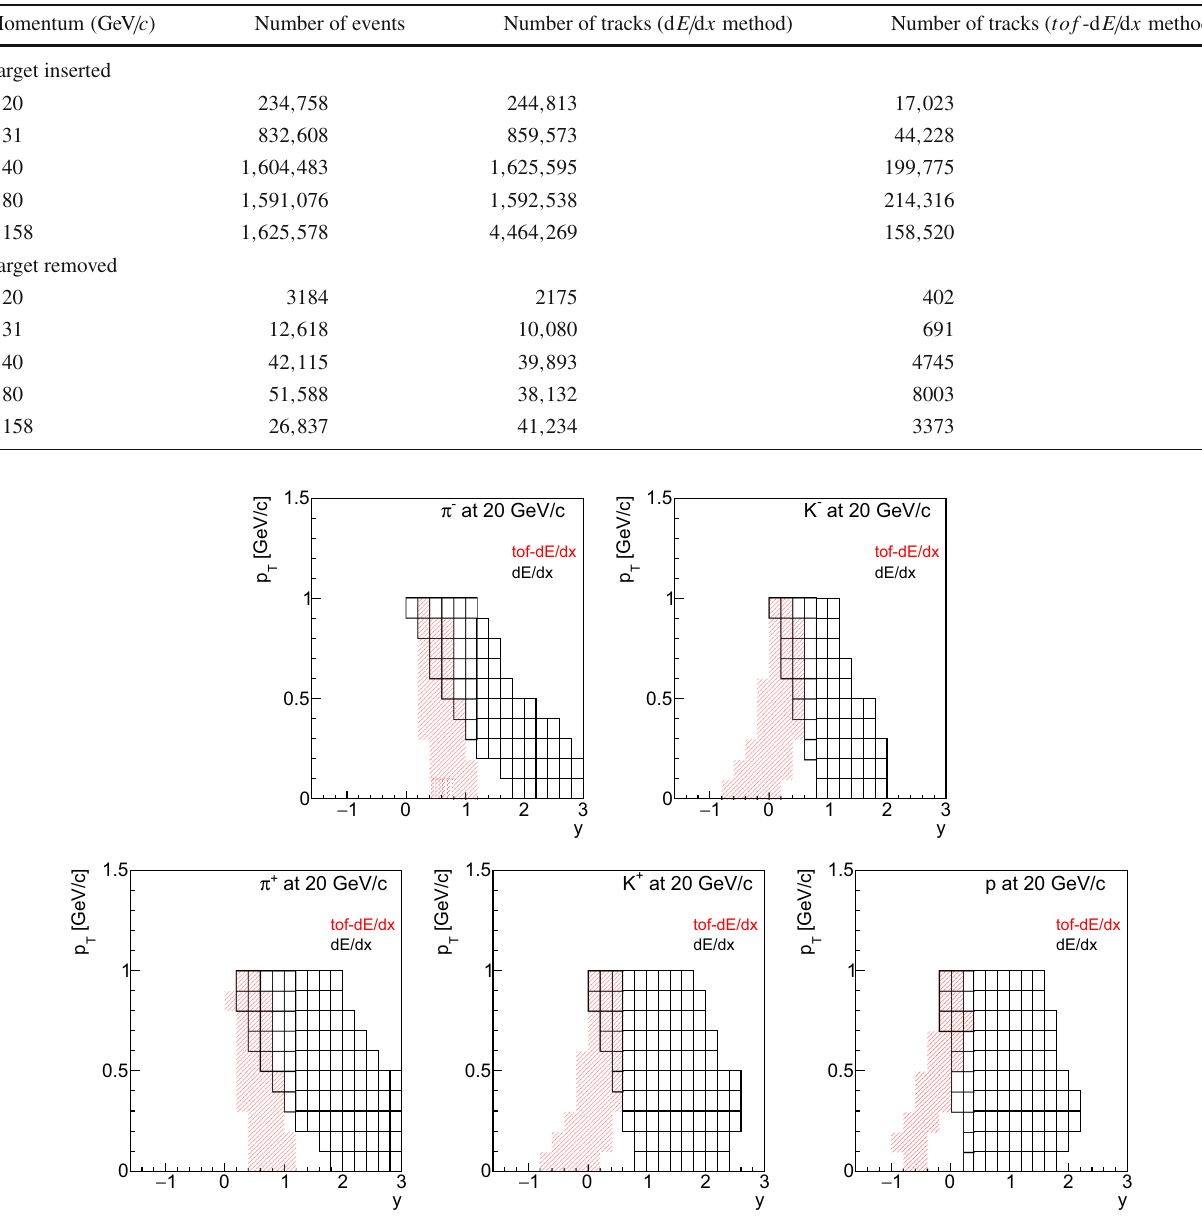
LHT. The event statistics collected in the two configurations are summarised in Table